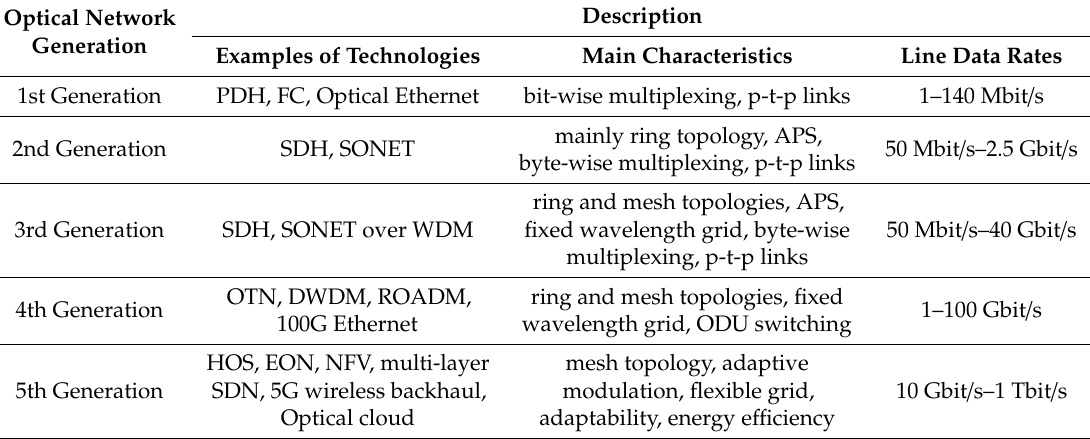
Table 3. Evolution of optical network capacity and functionality represented by five network